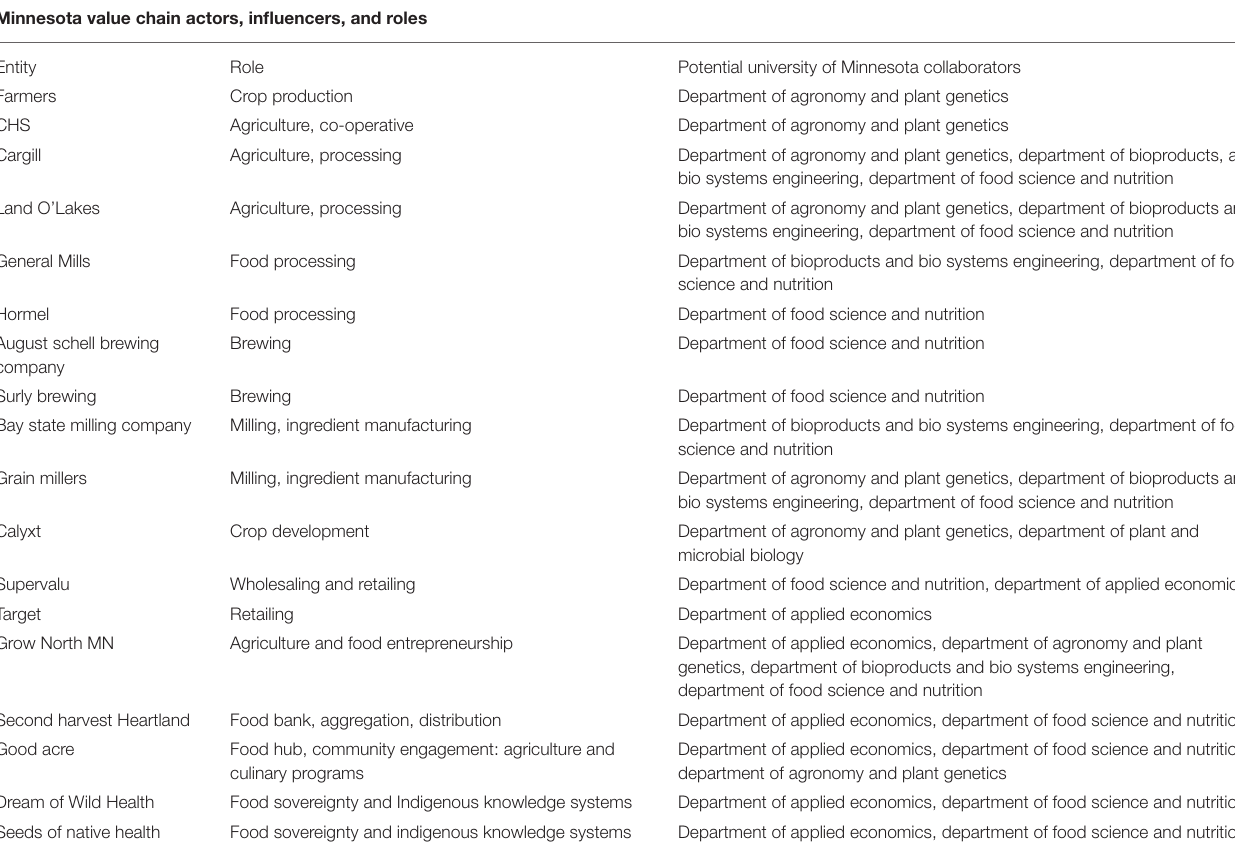
TABLE 2 | Recommendation of potential collaborations between Value chain actors and influencers, and the University of Minnesota. Minnesota value chain actors, influencers, and